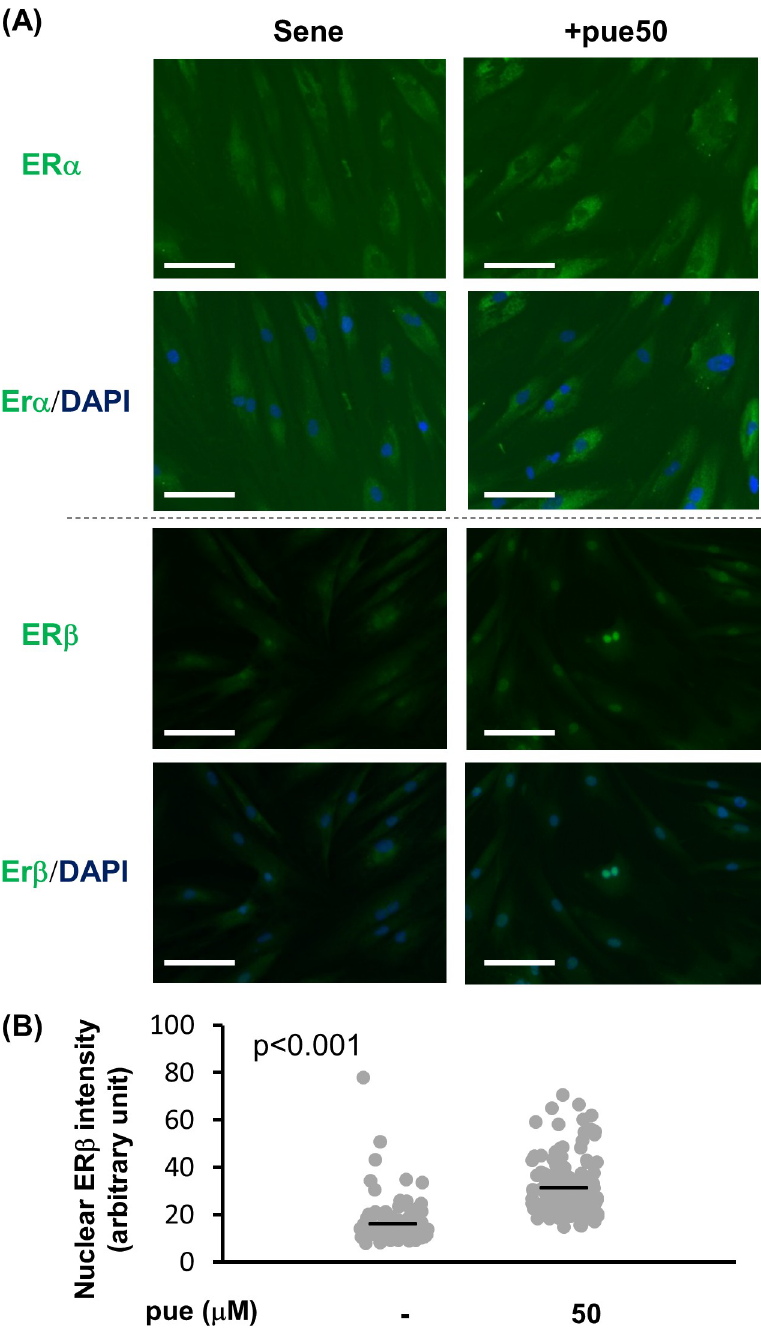
Fig 7. The effect of puerarin on the translocation of estrogen receptors in senescent NHDFs. (A) Senescent (sene) NHDFs with or without 50 μ M puerarin (+pue 50) were stained for ER α (upper) or ER β (lower) by the immunocytochemical method. (B) Fluorescent intensities of ER β that translocated into nuclei were calculated from more than 100 nuclei (3 microscpic fields) for each group. Scale bars = 50 μ m. assay (live-dead assay, S4 Fig), whereas we observed a reduction in the proportion of SA-beta- galactosidase-positive cells after puerarin treatment. Taken together, puerarin may not be con- sidered as a senolytic agent for senescent NHDFs.